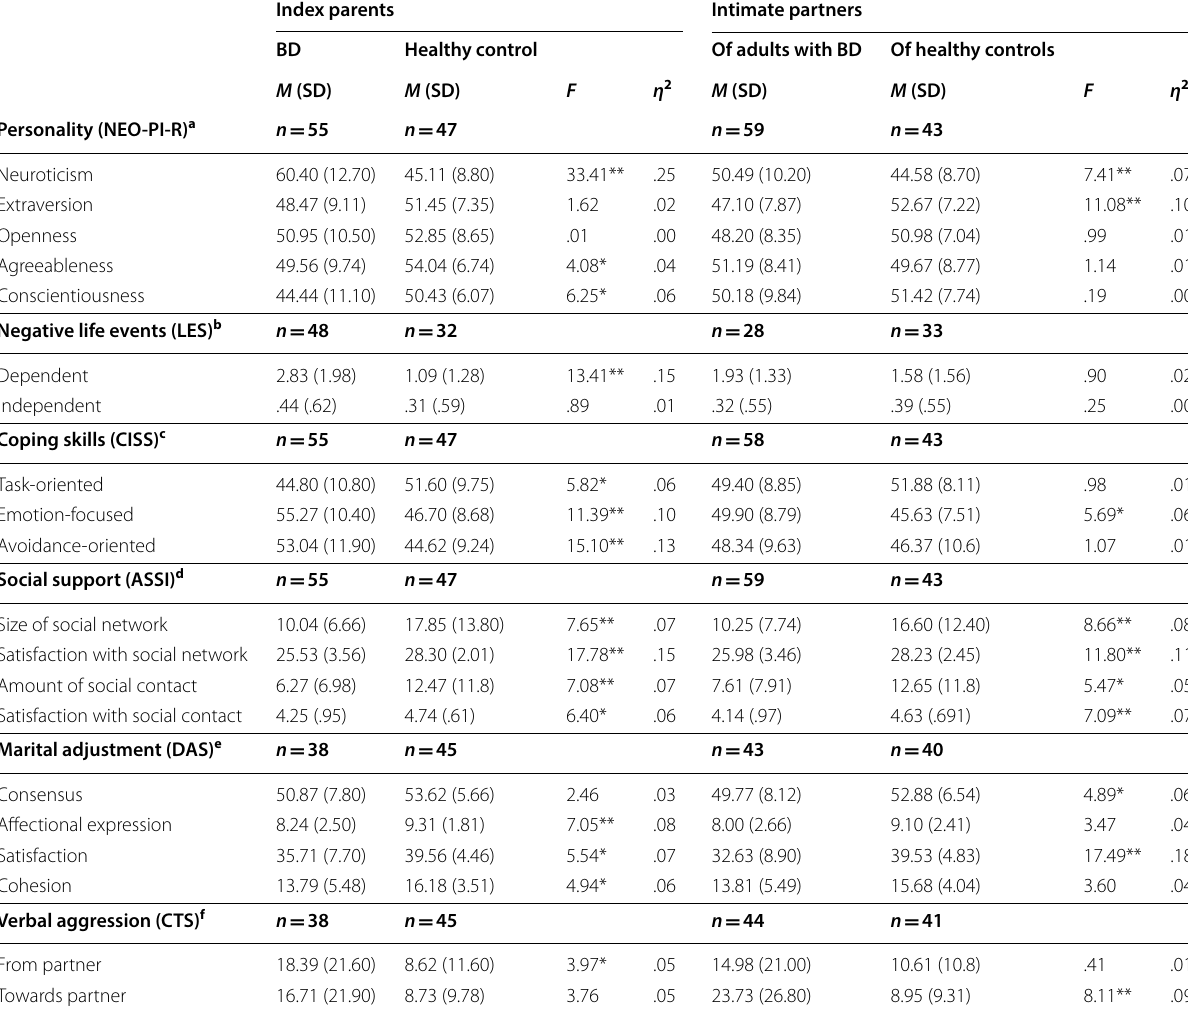
Table 1 Comparisons of personality traits, psychosocial functioning, and marital adjustment of index parents with bipolar disorder (BD) and index healthy control parents and of intimate partners of parents with BD and intimate partners of healthy control